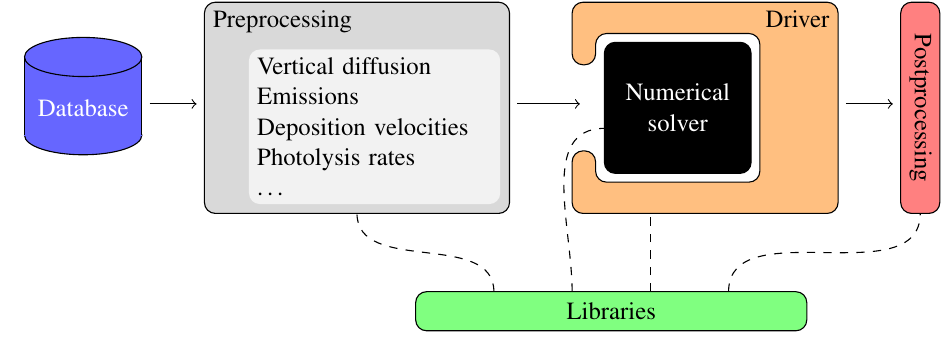
Fig. 1. A view on Polyphemus design: database storing all raw data, preprocessing stages for most physical computations, drivers in which the numerical solver is embedded, postprocessing and libraries that may be called at any time.